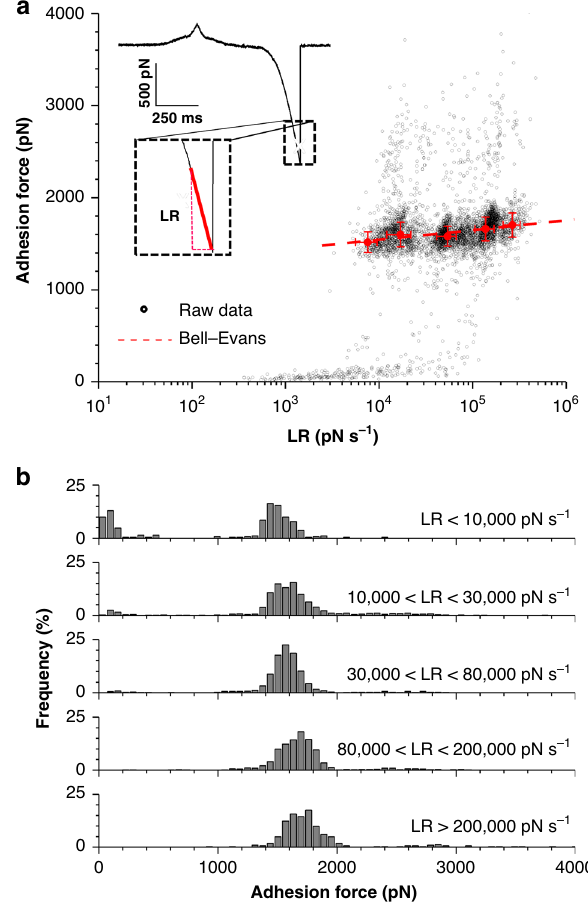
Fig. 3 Binding of SpsD to fi brinogen is enhanced by tensile force. ( a ) Dynamic force spectroscopy plot obtained by recording force – distance curves in PBS between Fg-tips and S. pseudintermedius ED99 SpsD cells ( n = 4326 data points from 4 cells). Inset shows a representative force vs time curve, highlighting the way the loading rate ( LR ) is extracted. A Bell Evans model fi t (dashed red line) through the most-probable rupture force and force LR shows the expected force loading-rate dependency of the force ( x β = 0.090 nm k off = 5.07 × 10 − 13 s − 1 ). ( b ) Corresponding rupture force histograms as a function of discrete ranges of LRs , emphasizing the shift toward higher forces with increasing LRs